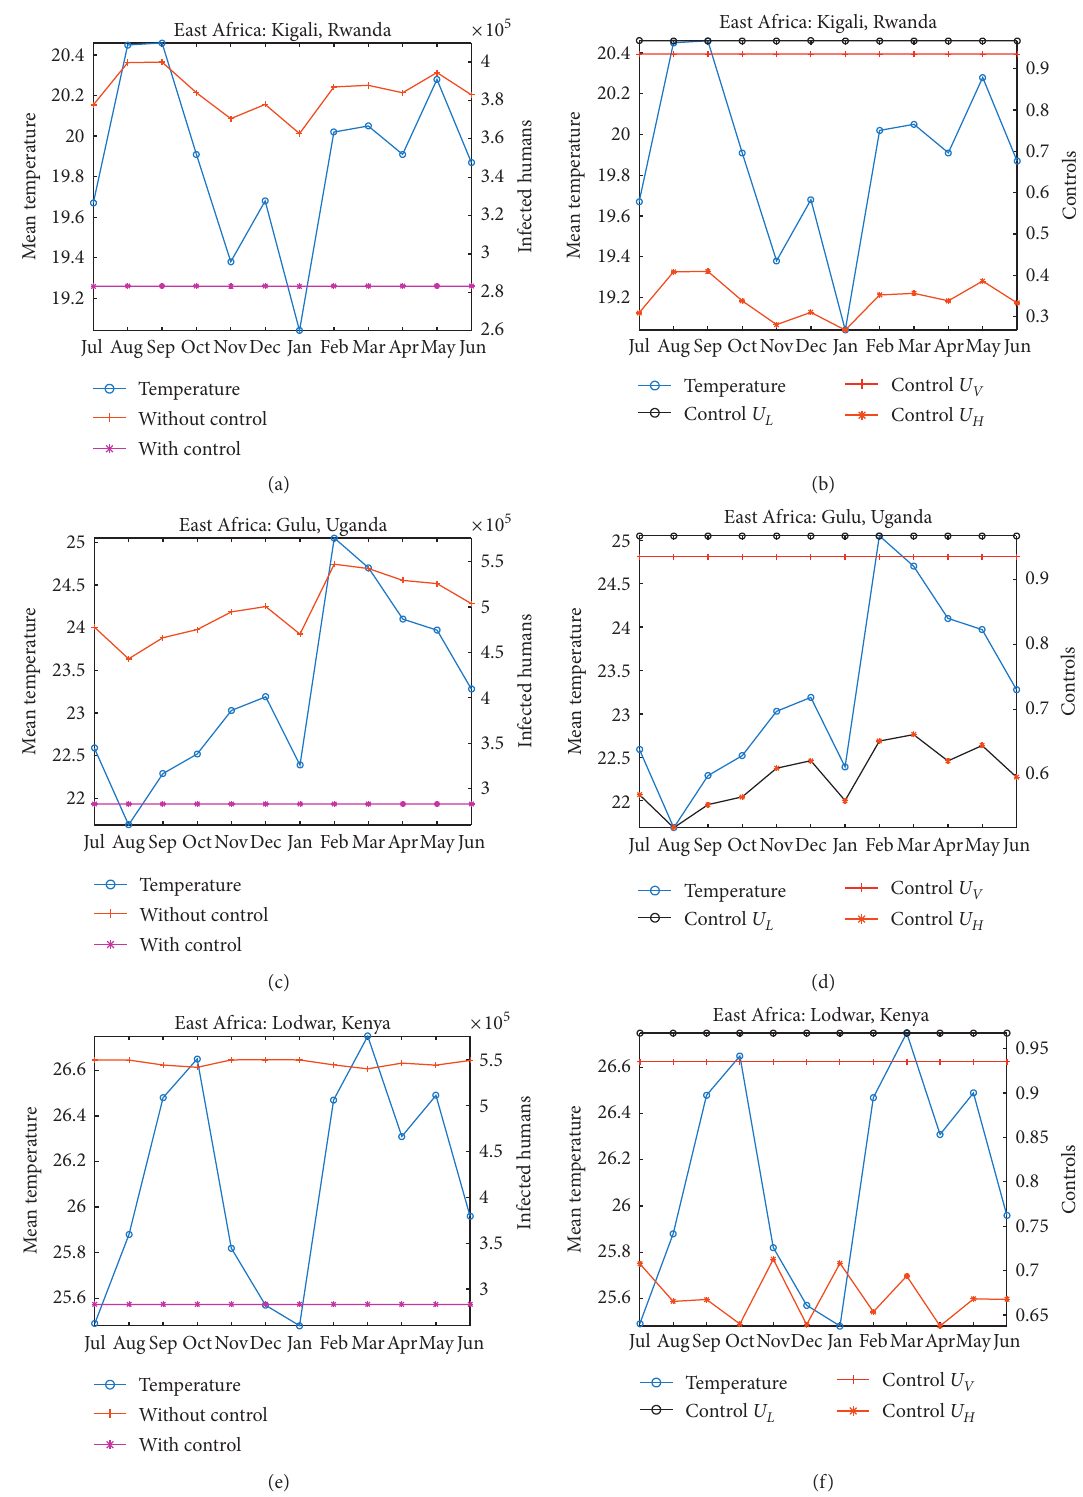
Figure 7: Simulations of the model (2) as a function of time: (a, c, e) the monthly total number of infected humans without and with controls and (b, d, f) optimal controls u H ( t ) ,u L ( t ) , and u V ( t ) , in Kigali, Rwanda; Gulu, Uganda; and Lodwar, Kenya; in East Africa. The mean monthly temperature is plotted in blue lines and is superimposed onto each